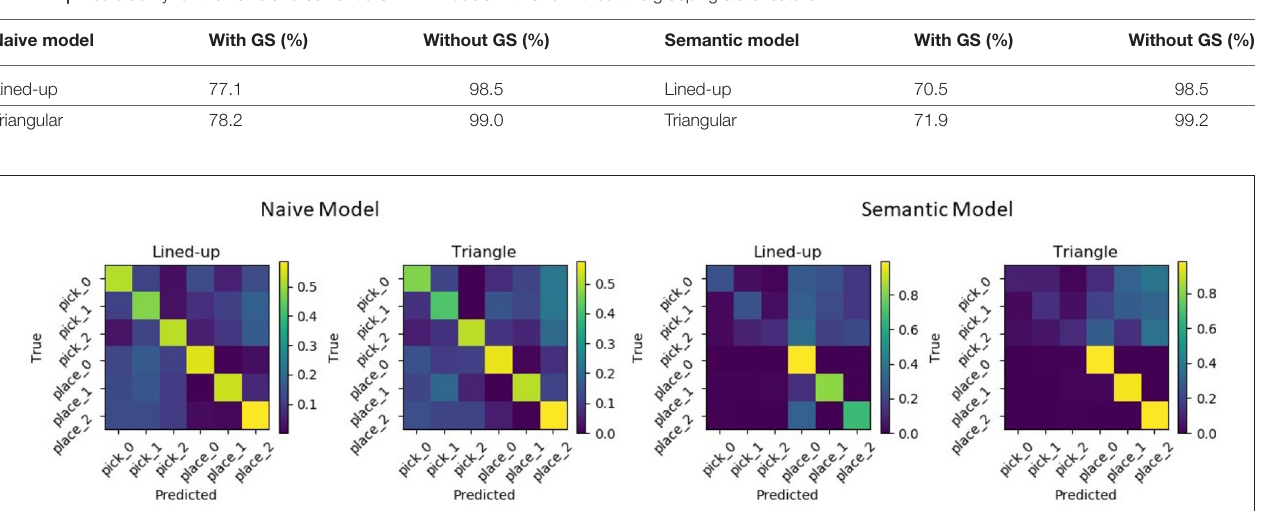
TABLE 1 | Accuracy for the naive and semantic GHMM models with and without the grasping state feature. Naive model With GS (%) Without GS (%) Semantic model Lined-up Triangular 75.3